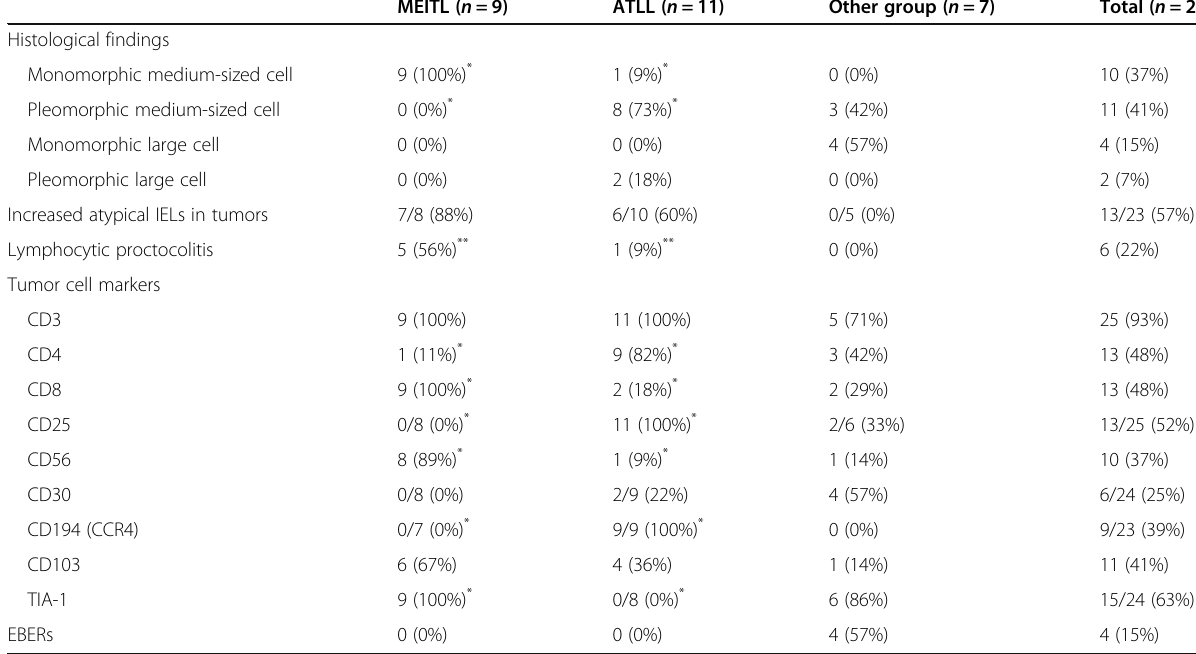
Table 3 Pathological and immunohistological findings of 27 colorectal T/NK cell lymphoma patients